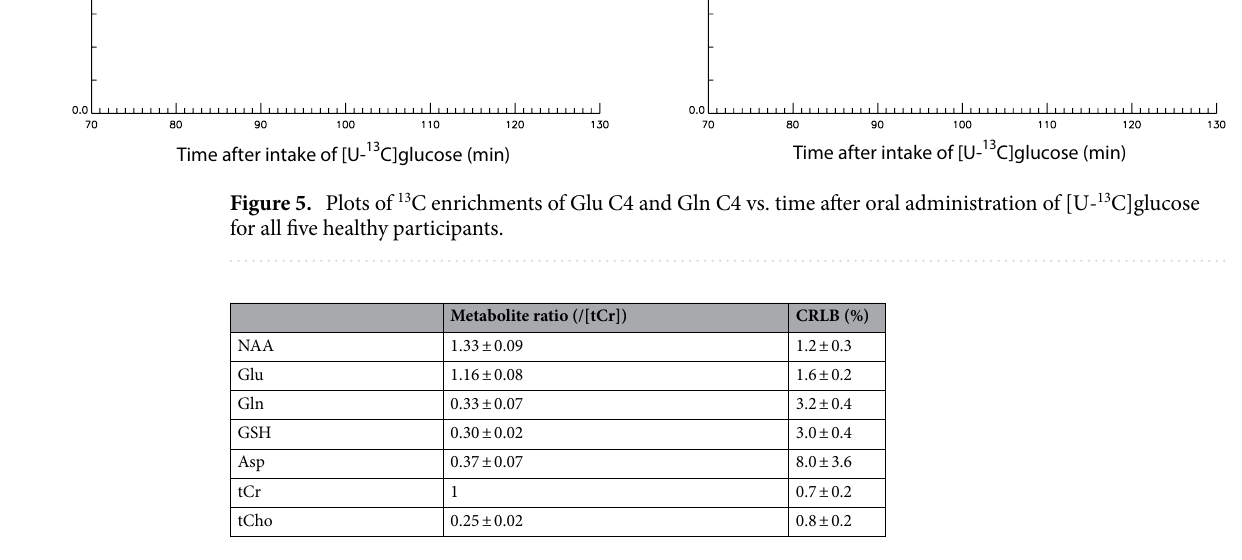
Table 1. Metabolite ratios (/[tCr]) in the dACC of five healthy participants quantified from the pre- 13 C spectrum of each participant. Voxel size = 3.5 × 1.8 × 2 cm 3 ; TR = 2.2 s; TE = 56 ms; spectral width = 4000 Hz; number of data points = 1024; number of averages = 264; and total scan time = 10